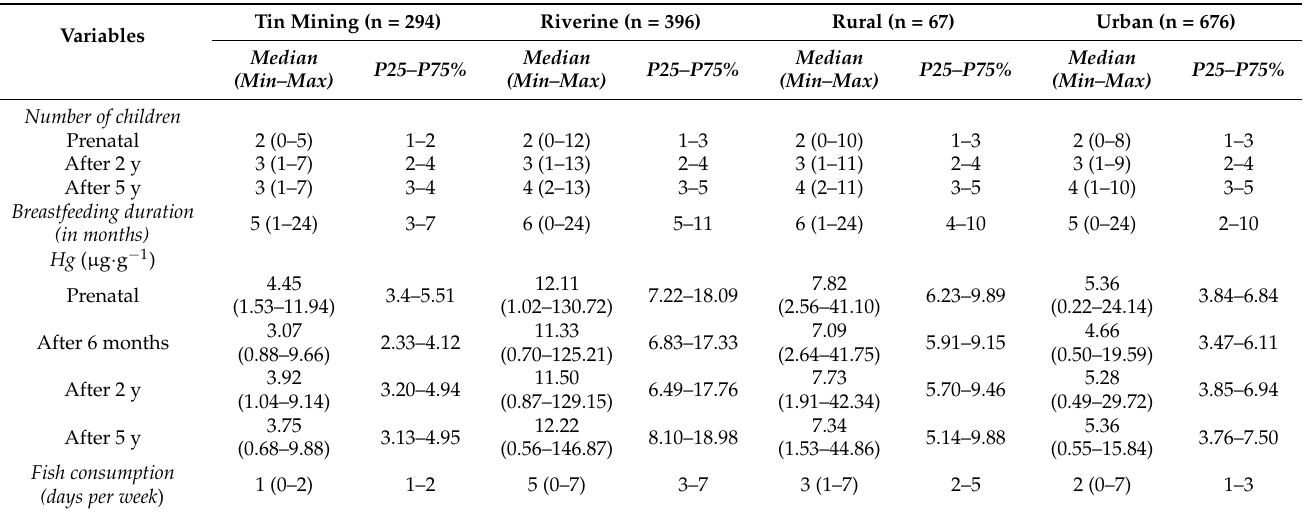
Table 3. Number of children, breastfeeding duration, total Hg levels (in µ g · g − 1 ), fish consump- tion frequency, according to place of residence of studied women (n = 1433), Rond ô nia State, Brazilian